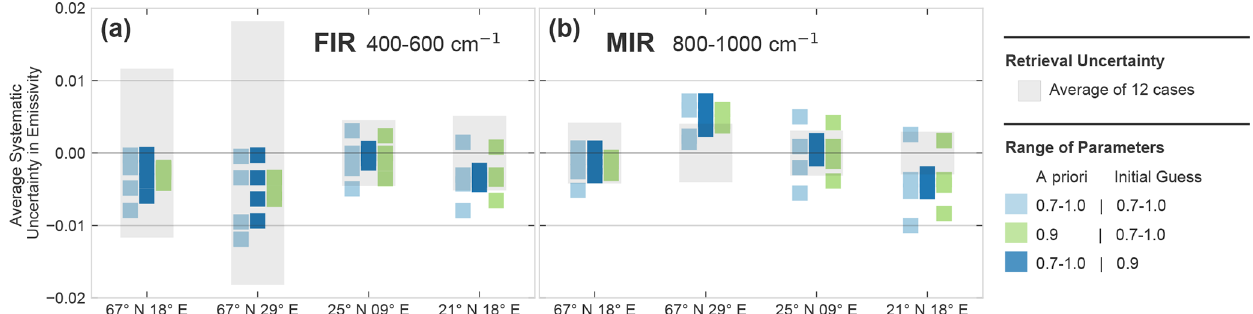
Figure 8. Systematic uncertainty in emissivity retrievals caused by the different choice of emissivity a priori or the initial guess for four geographical scenes. Except for the choice of emissivity initial guess and a priori, all details can be found in Sect. 3. The coloured squares show the spectrally averaged value of systematic uncertainty in the retrieved emissivity for different variations of the parameters. Panels (a) and (b) show the average values in 400–600 and 800–1000cm − 1 , respectively. In dark blue, the initial guess is kept constant at 0.9, and the a priori takes the values of 0.7, 0.8, 0.9 and 1.0. In light green, the a priori is kept constant at 0.9, and the initial guess takes the values of 0.7, 0.8, 0.9 and 1.0. In light blue, the a priori and initial guess take the same values of 0.7, 0.8, 0.9 and 1.0. For reference, the average value of the 1 σ retrieval uncertainty from all 12 parameter combinations is shown as a dashed grey region in the background. Note that the ranges in all four figures are very small in extent, and the scale of the y axis is ± 0.02 to highlight the